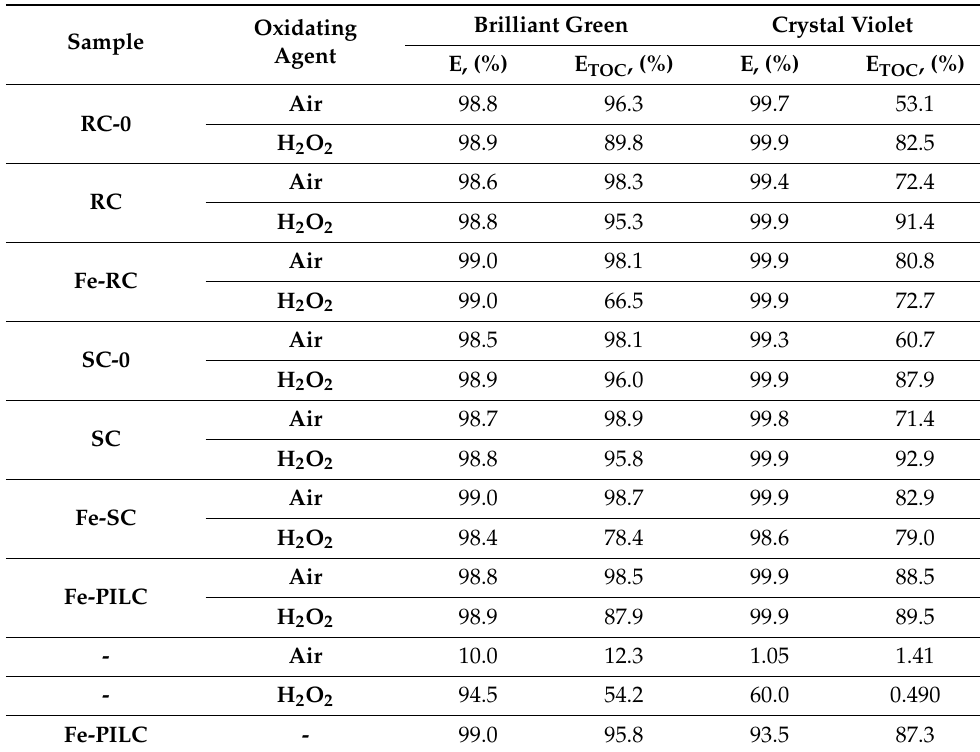
Table 2. Efficiency values for CWAO and CWPO process (100 mg/L dye concentration). Brilliant Oxidating Sample Agent